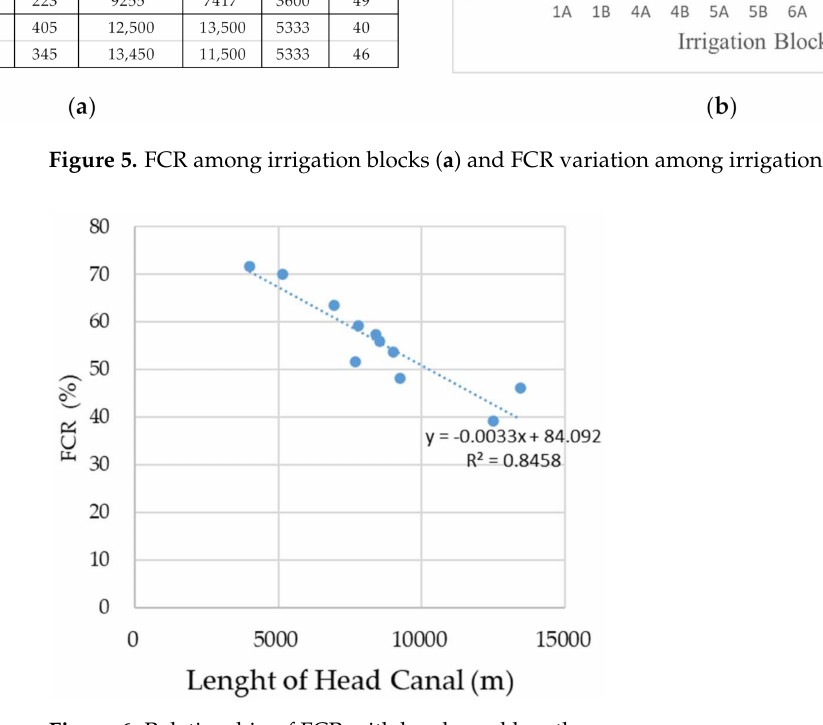
Figure 6. Relationship of FCR with head canal